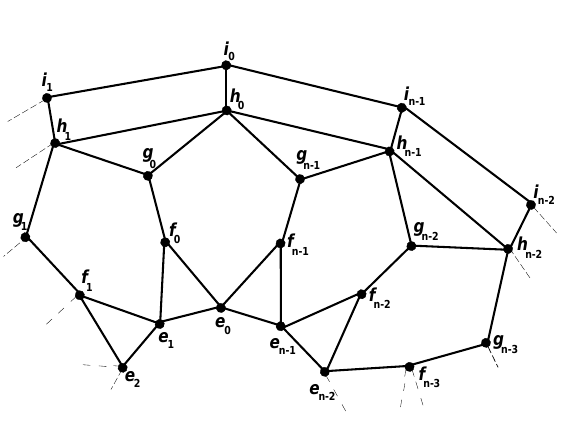
Figure 10. The graph of convex polytope R (cid:48) n